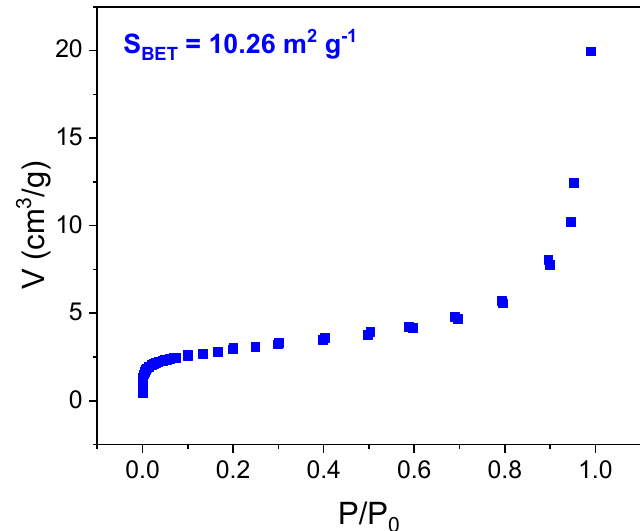
Figure 15. N 2 adsorption–desorption isotherm of goethite at 77 K, used as a solid